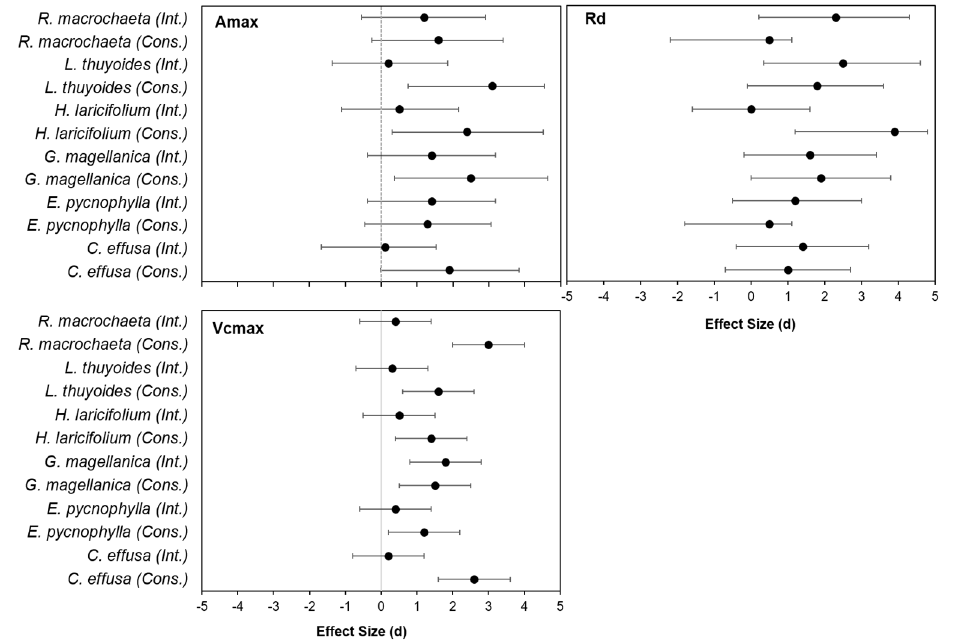
Figure 4. Size of the effect of the OTC treatment on the parameters Amax, Rd and Vcmax_app, derived from the response curves to light and response curves to CO 2 after one year of passive warming in the species E. pycnophylla , H. laricifolium , L. thuyoides , R. macrochaeta , C. effusa and G. magellanica from the conserved and intervened areas.